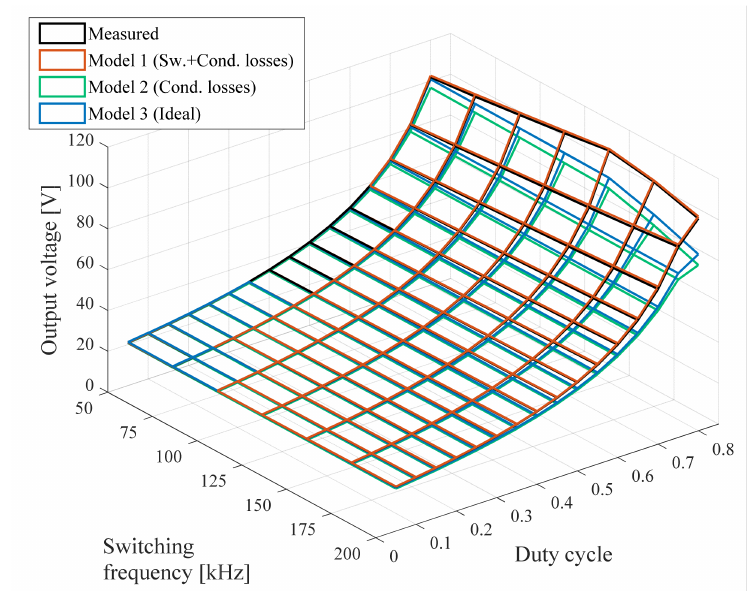
Figure 13. Predicted output voltage for known input voltage, input current and duty cycle.